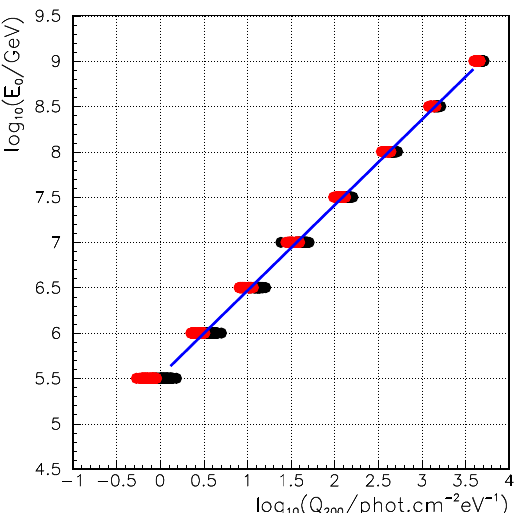
Figure 5. CORSIKA simulated recalculation from Q 200 to the primary energy.